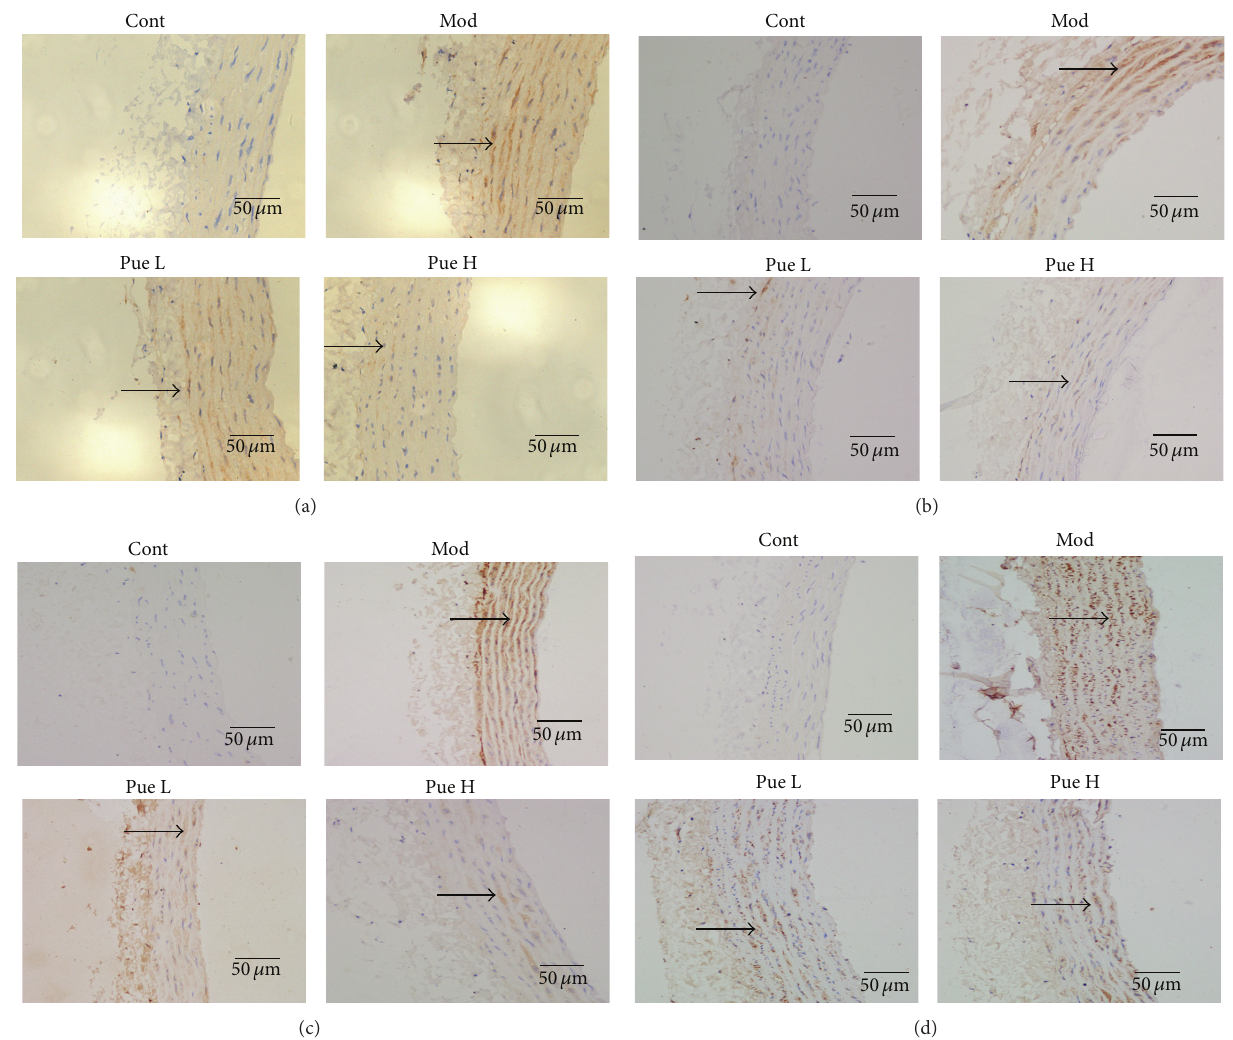
Figure 7: Effect of puerarin on localization of ICAM-1 (a), NOX2 (b), NOX4 (c), and NF- 𝜅 B p65 (d) proteins in the aorta as revealed by immunohistochemistry. Arrows, intensive